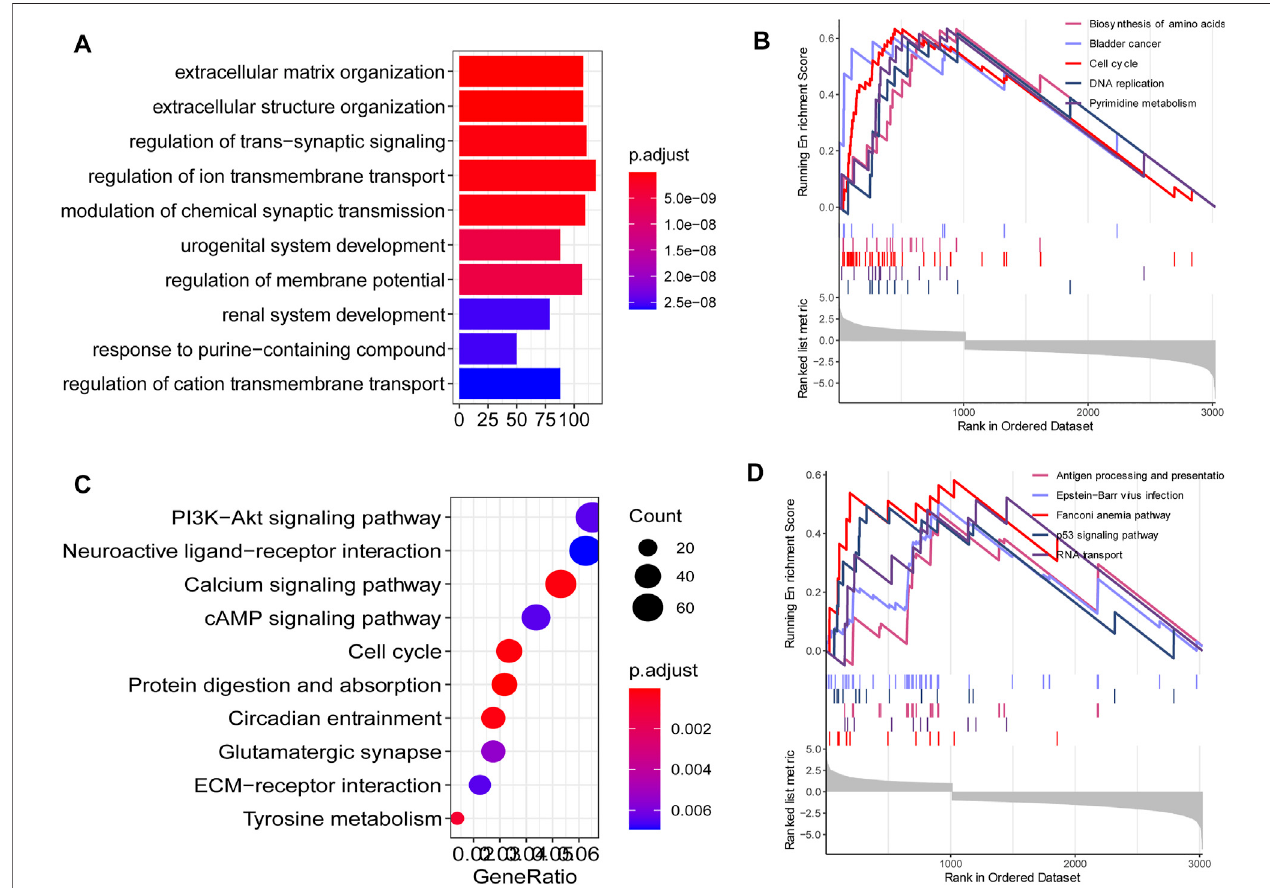
FIGURE 2 | Functional annotation. (A) The top 10 enriched biological process in gene oncology. (C) The top 10 KEGG pathways in gene oncology. (B, D) The top 10 KEGG pathways in GSEA fi ndings.